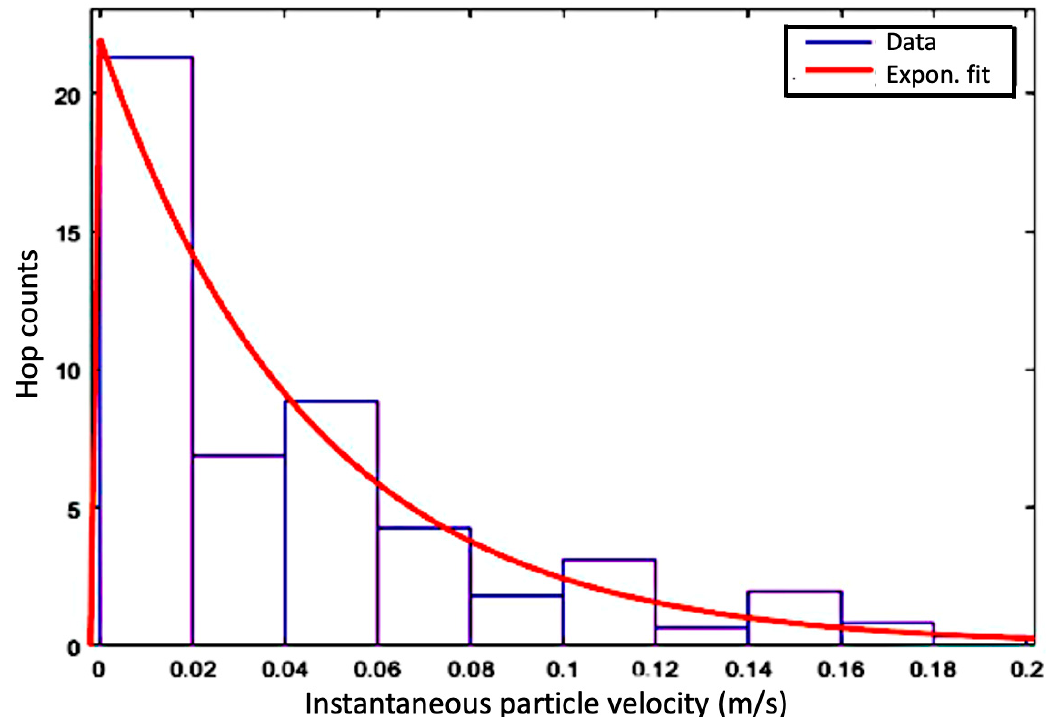
Figure 10. Empirical and modeled (exponential) distribution of instantaneous instrumented particle streamwise velocities for the flow rate of 49 (L/s), particle density of 1132 (kg/m 3 ), and bed surface A.